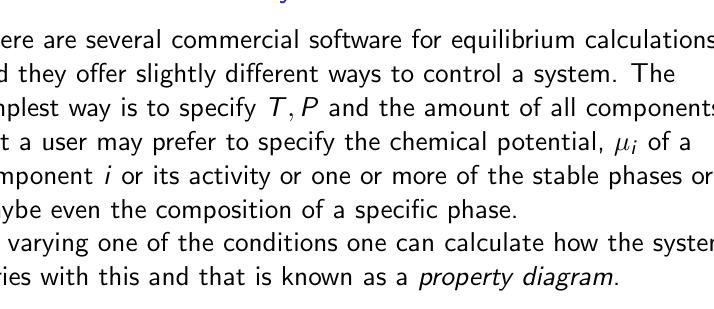
The heat capacity of UO 2